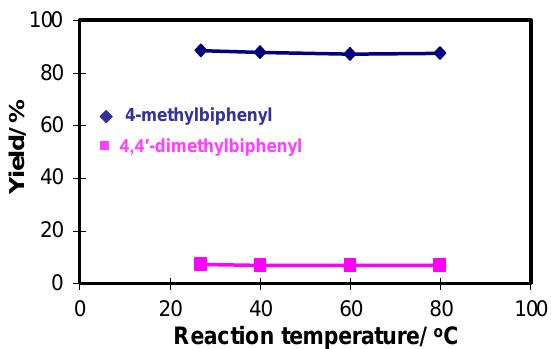
Figure 7. The thermal stability test of the microreactor M1 at various temperatures for the reaction of bromobenzene with 4-methylphenylboronic acid. Reaction time inside M1 was 12 s. Mole ratio of bromobenzene/4-methylphenylboronic acid/Na 3 PO 4 =